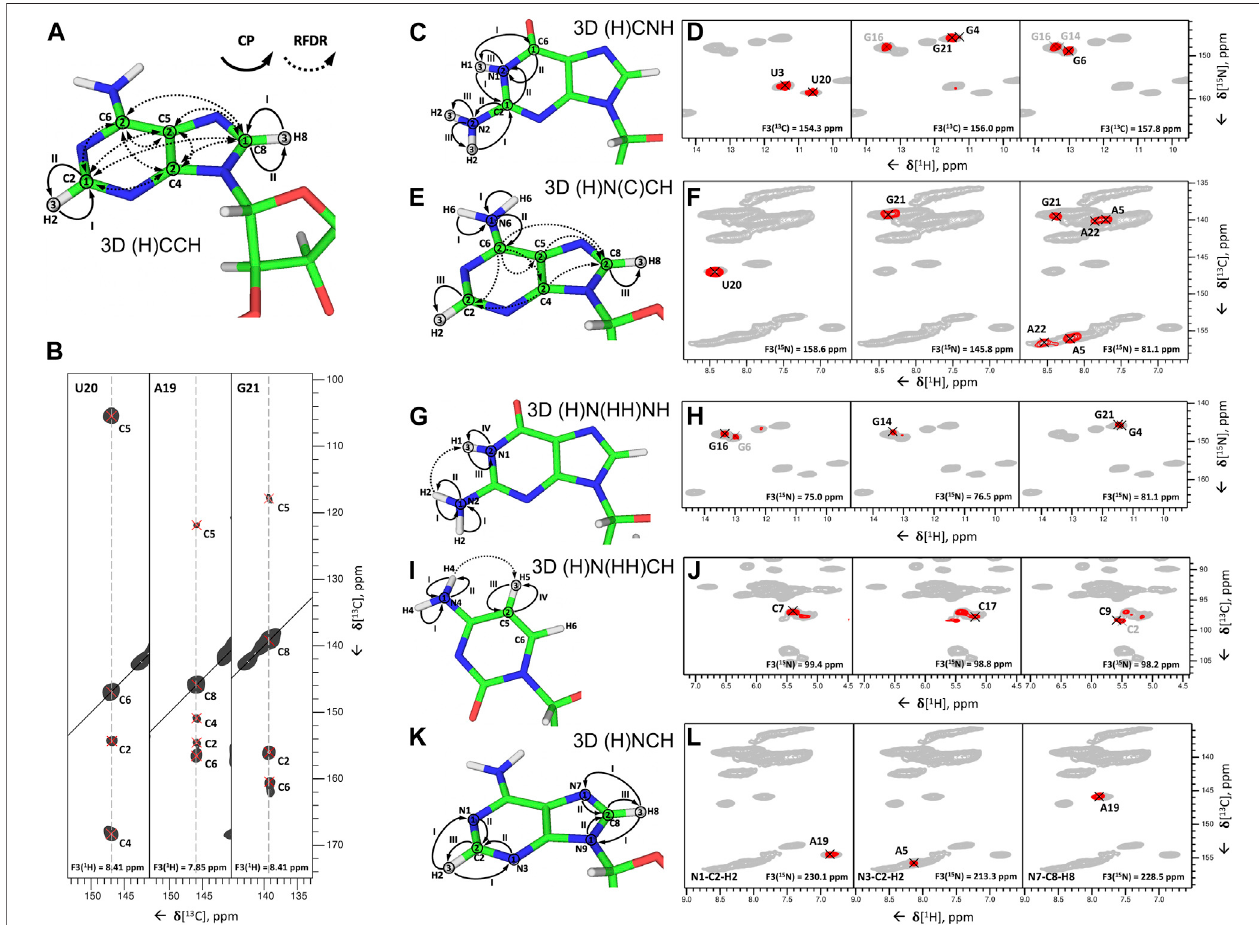
FIGURE 7 | Nucleobase assignment by 1 H-detected ssNMR. (A,C,E,G,I,K) Magnetization transfers for (A) 3D (H)CCH, (C) 3D (H)CNH, (E) 3D (H)N(C)CH, (G) 3D (H)N(HH)NH, (I) 3D (H)N(HH)CH experiments, and (K) 3D(H)NCH experiments, shown on the example of adenosine (A,E,K) , guanosine (C,G), and cytidine (I) . Solid arrows indicate CP transfers and dotted arrows indicated RFDR transfers; Arabic numbers indicate spectral dimensions (t 1 – t 3 ); Roman numbers indicate CP transfers. (B,D,F,H,J,L) Assignmentofbase spin systemsin the26mer BoxC/DRNAwith (B) 3D(H)CCH, (D) 3D(H)CNH, (F) 3D(H)N(C)CH, (H) 3D(H)N(HH)NH, (J) 3D (H) N(HH)CH, and (L) (H)NCH experiments. In (B) representative 2D 13 C – 13 C planes extracted from the 3D (H)CCH spectrum show correlations of all intra-nucleotide nucleobase carbons for the nucleotides U20, A19, and G21. In (D) representative 2D planes extracted from the 3D (H)CNH experiment show correlations of imino nitrogens with distinct nucleobase carbon resonances for the nucleotides U3, U20, G4, G16, G21, G6, and G14. In (F) representative 2D planes extracted from the 3D (H)N(C)CH experiment show correlations of imino and amino nitrogens with protonated nucleobase carbons for the nucleotides U20, G21, A5, and A22. In (H) representative 2D planes extracted from the 3D (H)N(HH)NH experiment show correlations of amino and imino nitrogens of guanosines for the nucleotides G16, G6, G14, G21, and G4. In (J) representative 2D planes extracted from the 3D (H)N(HH)CH experiment show correlations of amino nitrogens with protonated carbons of cytidines for the nucleotides C7, C17, C9, and C2. In (L) representative 2D planes extracted from the 3D (H)NCH experiment show correlations of non-protonated nitrogens with protonated carbons for the nucleotides A19 and A5. 13 C or 15 N frequencies are indicated in each panel. Peaks labeled in gray indicate that the peak maximumisnotintheplaneshownhere.Forreferenceinpanels (D,F,H,J,L) ,theredcontoursof3DH(C)NHand(H)N(HH)NHspectra (D,H) areoverlaidonto2D 1 H- 15 N CP-HSQC spectra (in gray), while red contours of 3D (H)N(C)CH, (H)N(HH)CH and (H)NCH spectra are overlaid onto 2D 1 H- 13 C CP-HSQC spectra (in gray), tailored either for the C2-H2/C6-H6/C8-H8 (F,L) or the ribose/C5-H5 spectral regions (J) . All spectra were recorded on an 850 MHz spectrometer at a MAS frequency of 100 kHz (Aguion et al., 2021). All spectra are adapted from (Aguion et al., 2021).